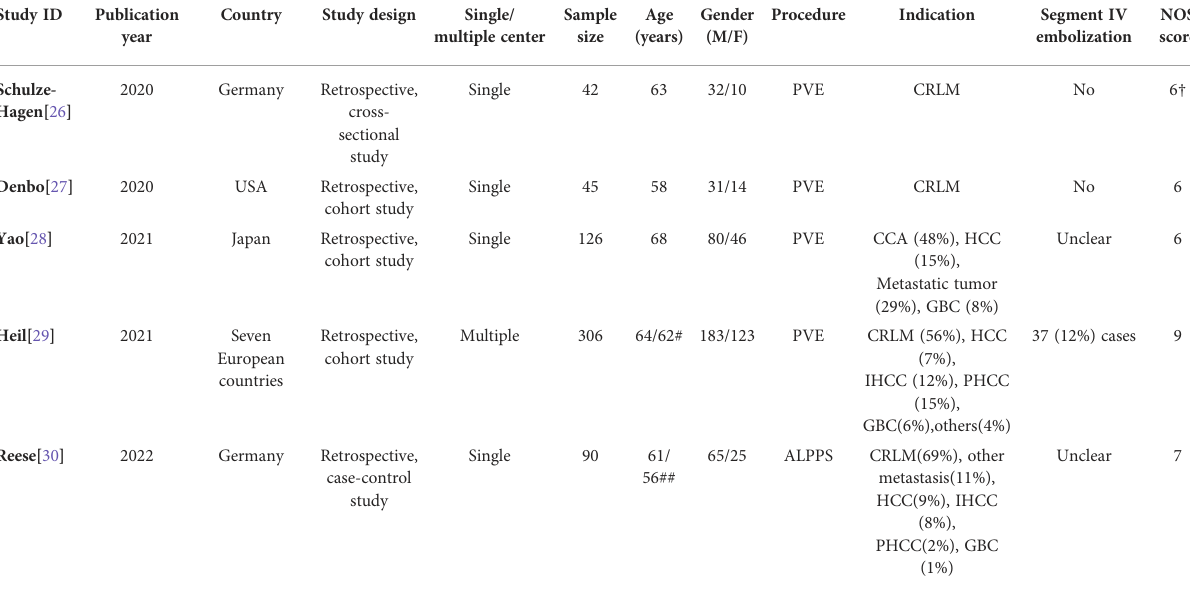
TABLE 1 Study and patient